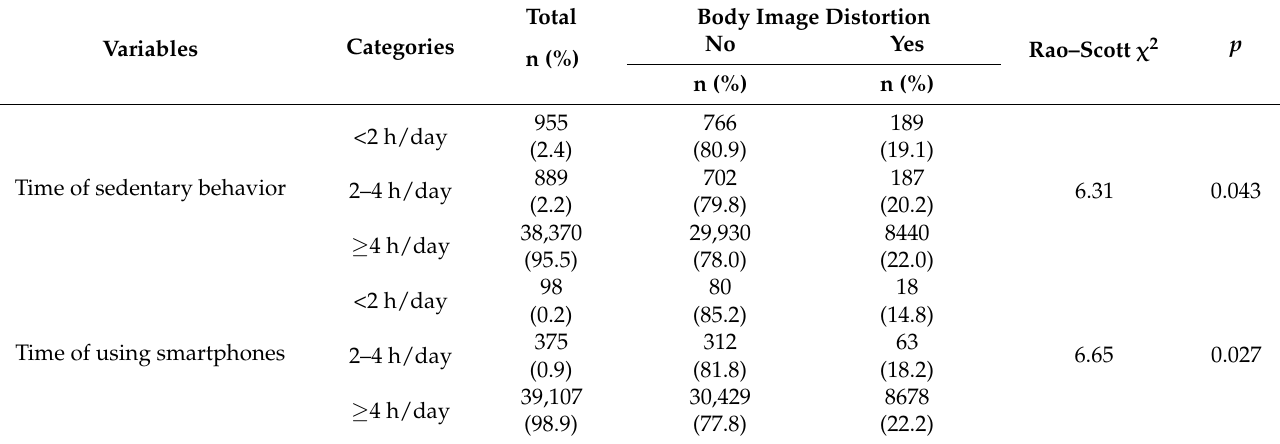
Table 4. Differences in body image distortion according to the time of sedentary behavior and smartphone use during leisure time. The values are presented as the mean ± standard error or unweighted number (weighted